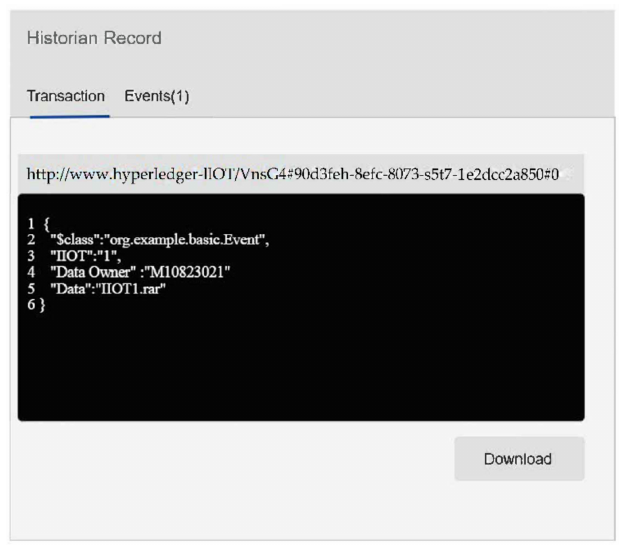
Figure 18. Manufacturers obtain URL-related information.